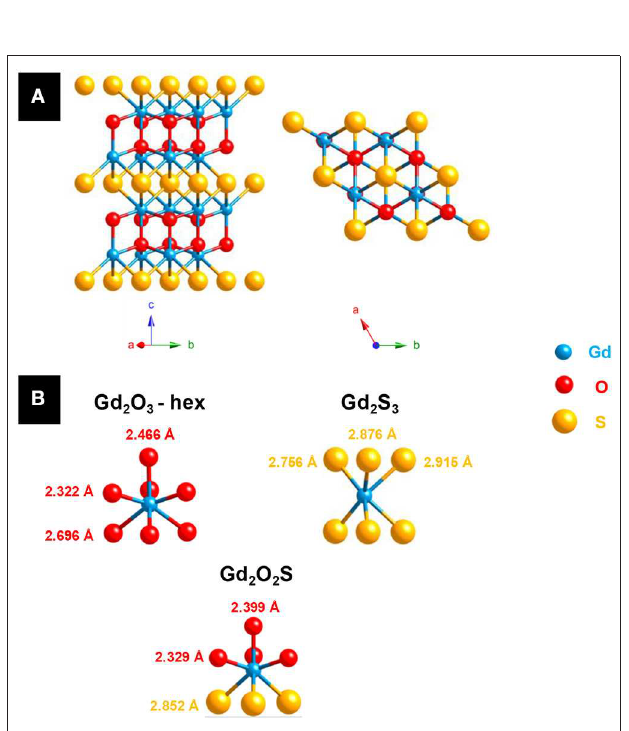
FIGURE 2 | (A) Ln 2 O 2 S structure: a hexagonal layered structure (Ln = Gd). (B) Lanthanide environment in hexagonal lanthanide oxide Ln 2 O 3 (JCPDS 02-1878), lanthanide sesquisulfide Ln 2 S 3 (JCPDS 03-2364) and lanthanide oxysulfide Ln 2 O 2 S (JCPDS 06-8819) with the example of gadolinium.